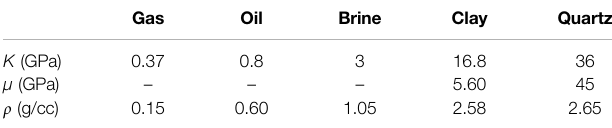
TABLE 2| Elastic moduliand densitiesused inthe rock-physics models [modi fi ed from Mavko et al.